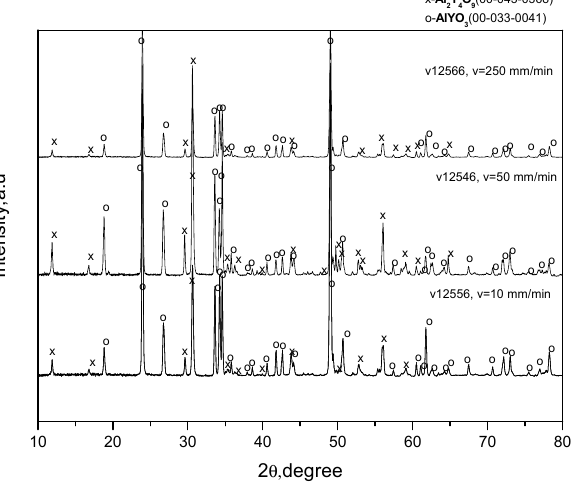
Figure 8. X-ray spectra of the fibers crystallized from the raw oxides sintered at 1650 °C at the crystallization rates shown in the graph fields.